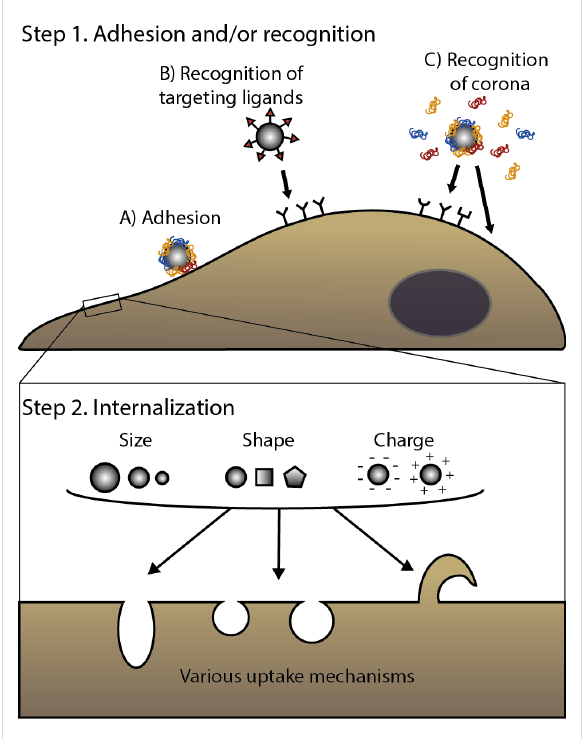
Figure 1: Interaction of nano-sized materials at the cell surface. First, nanoparticles adhere at the plasma membrane (A) and/or are recog- nized by cell receptors. Recognition can be achieved via targeting moieties, in the case of targeted nanomedicines (B) but also via the biomolecular corona (C) [10,11,17,18]. Secondly, nano-sized objects are internalized via various mechanisms (here illustrated by different shapes in the cell membrane or a membrane protrusion). However, we do not know yet how nanomaterial properties (such as size, shape, charge, as illustrated in the figure) affect or determine the mechanism cells use for the internalization